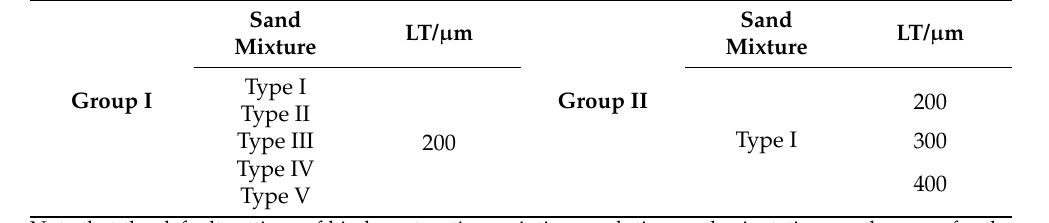
Table 1. Printing schemes of 3DP rocks.